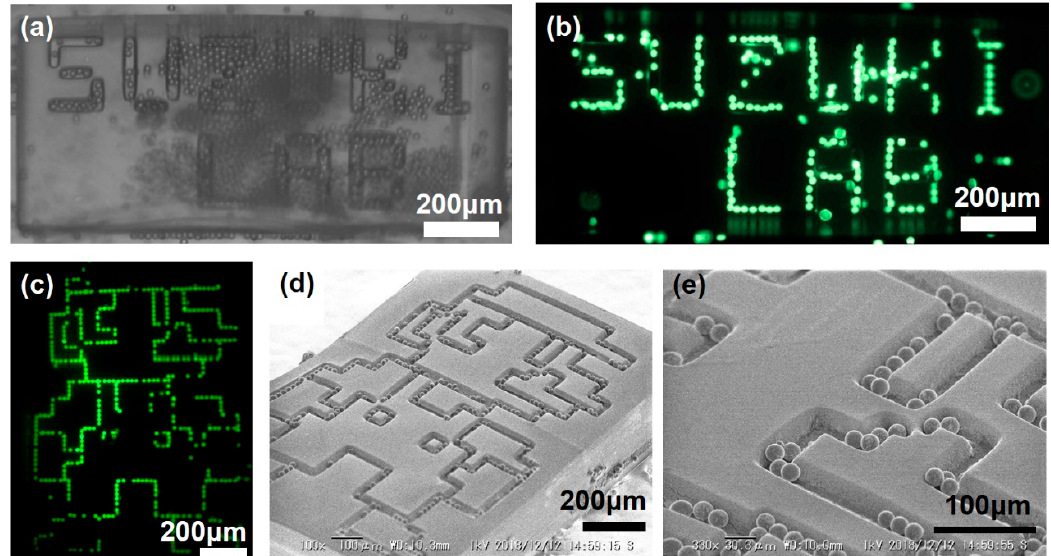
Figure 4. Assembly of fluorescent beads on the flat template having designed patterns trenches. ( a ) Bright field and ( b ) fluorescence microscope images of beads assembled letters. ( c ) Fluorescence microscope image and ( d , e ) SEM images of beads assembled to the pattern of a character.